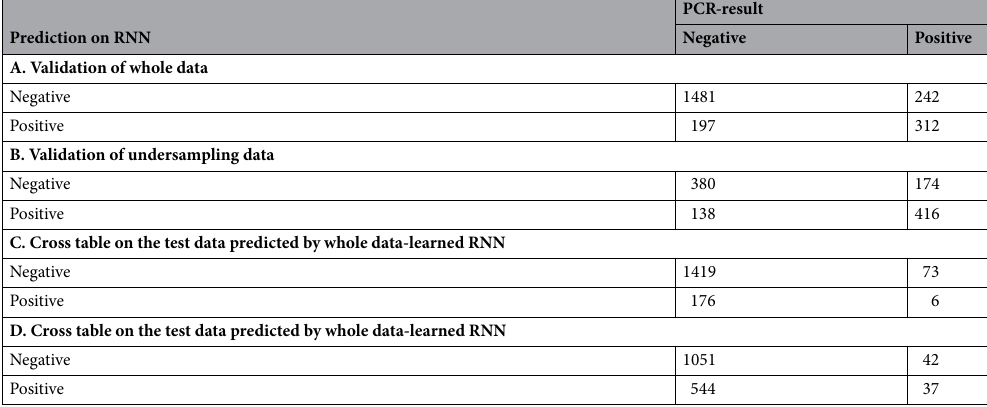
D. Cross table on the test data predicted by whole data-learned RNN